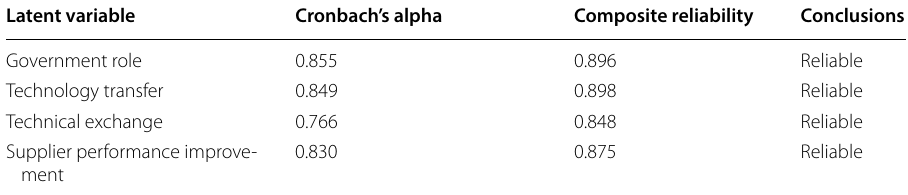
Table 7 Internal consistency reliability test. Source : Author Data, Smart PLS 3.2.7